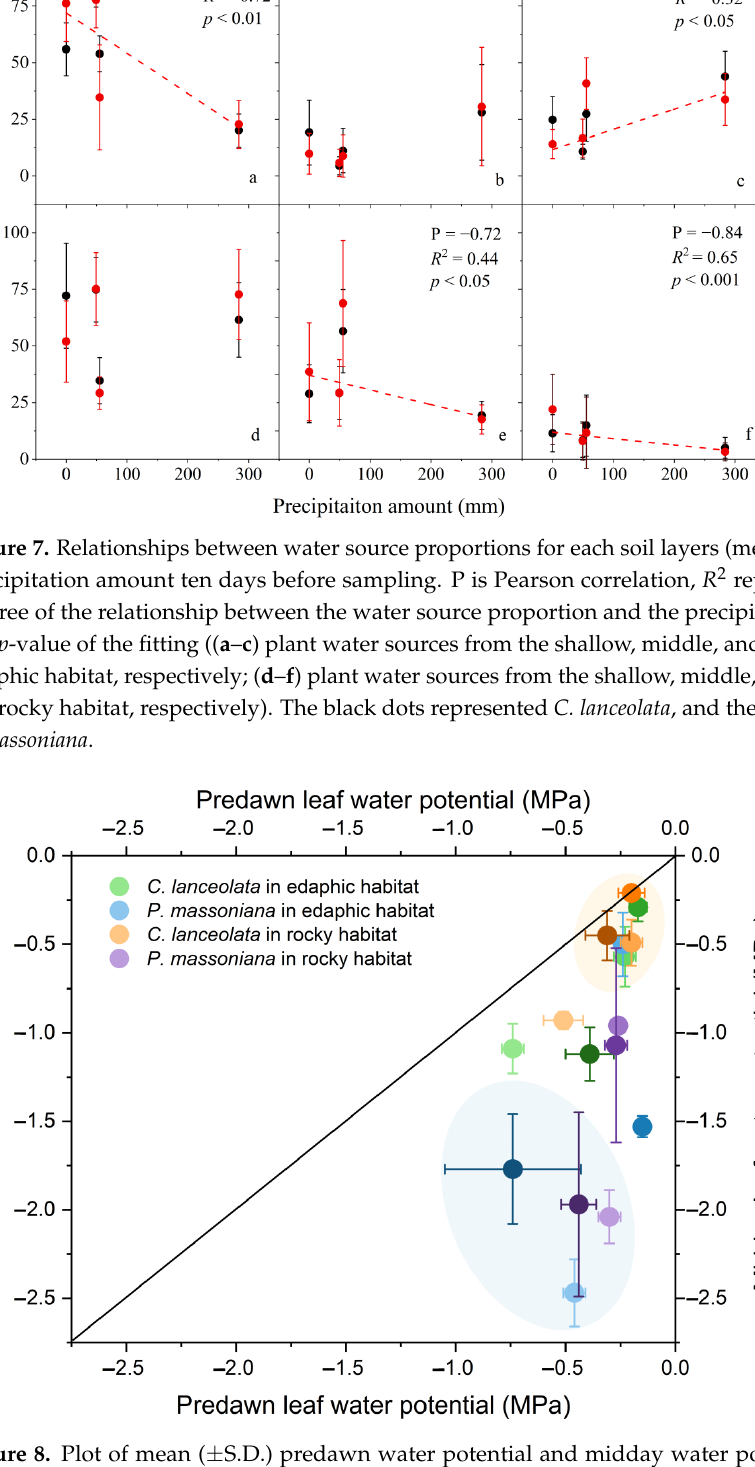
Figure 8. Plot of mean ( ± S.D.) predawn water potential and midday water potential of two tree species in the edaphic and rocky habitats. The black line is the 1:1 line of predawn water potential vs. midday water potential. The light to dark colors for each species represent the sampling dates as May-NP, June-HP, August-LP, and October-DP. The light orange shadow represents the cluster of trees close to the 1:1 line in HP and LP. The light blue shadow represents the cluster of trees away from the 1:1 line in NP and DP. The diurnal ranges of water potential (Δ ψ ) exhibited significant variation in differ- ent species with seasonal changes ( p < 0.01) (Figure 9). C. lanceolata showed significantly lower Δ ψ values than P. massoniana ( p < 0.001). The Δ ψ max value was the highest in NP for P. massoniana (−1.84 ± 0.19 MPa) and in DP for C. lanceolata (−0.45 ± 0.34 MPa). Both of the two tree species displayed the minimum Δ ψ (−0.48 ± 0.11 MPa and 0.09 ± 0.06 MPa, respectively) in HP and LP. Both of the two species showed significantly higher diurnal ranges of water potential in the edaphic habitat than those in the rocky habitat ( p < 0.001) during the sampling period, except for P. massoniana in LP and DP. Furthermore, there was no significant correlation between the Δ ψ values and water uptake depth for C. lan- ceolata or P. massoniana in the two habitats.